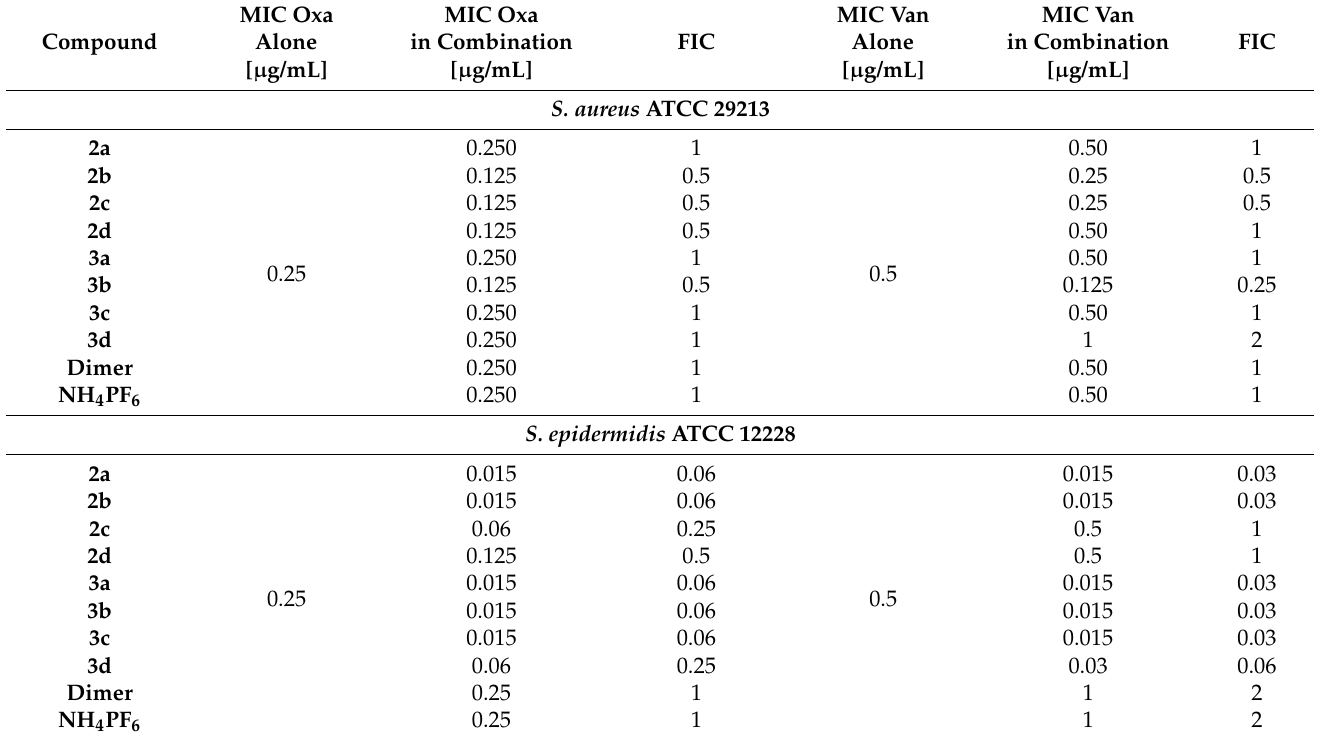
Table 3. Synergistic effect of arene-ruthenium(II) complexes used at 1 vancomycin (Van) used at the concentration range of 0.06–4 µ g/mL against S. aureus ATCC 29213 and 0.015–4 µ g/mL against S. epidermidis ATCC